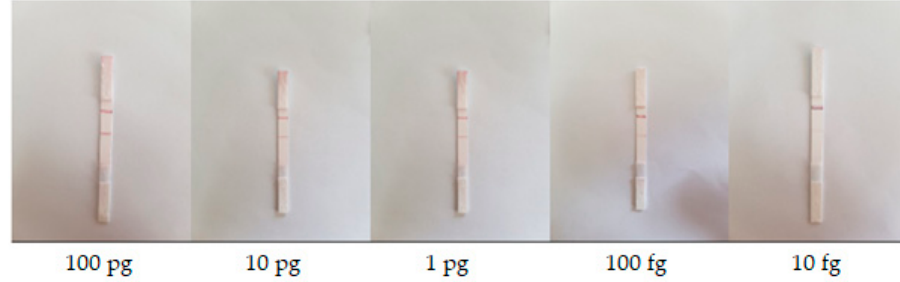
ff erent quantities of analyte under laboratory ambient lighting Figure 3. LFA strips for different quantities of analyte under laboratory ambient lighting condition. Figure 3. LFA strips for di